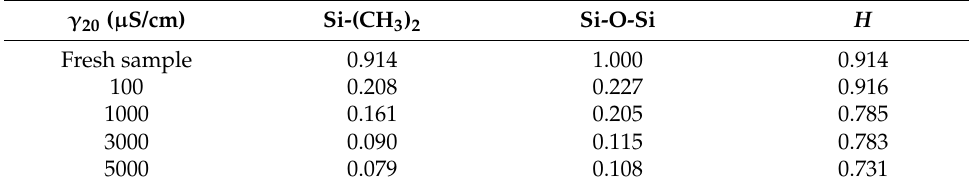
Table 8. The absorption peak height ratio of Si-O-Si and Si(CH 3 ) 2 (AC 3.6 kV, t = 8 h). γ 20 ( µ